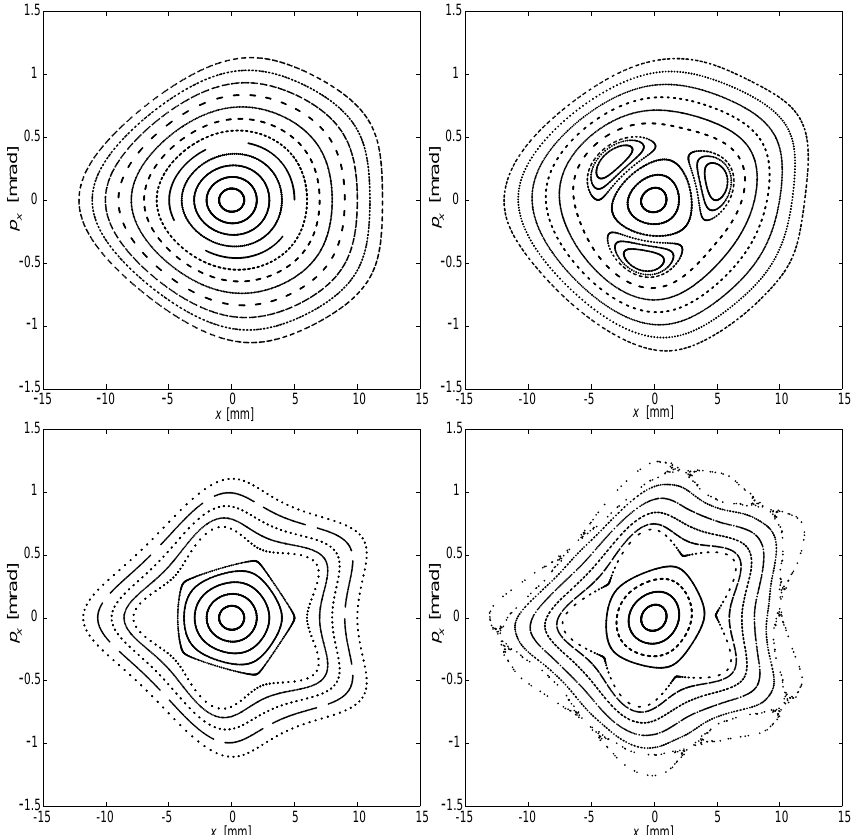
FIG. 13. Comparison of the horizontal phase space for an ideal machine (left) and one with uncorrected optic (right). The plots are made with the model tuned in the vicinity of the (cid:51) n (cid:120) (cid:173) (cid:52)(cid:51) (upper) and the (cid:53) n (cid:120) (cid:173) (cid:55)(cid:50) (lower) resonances.